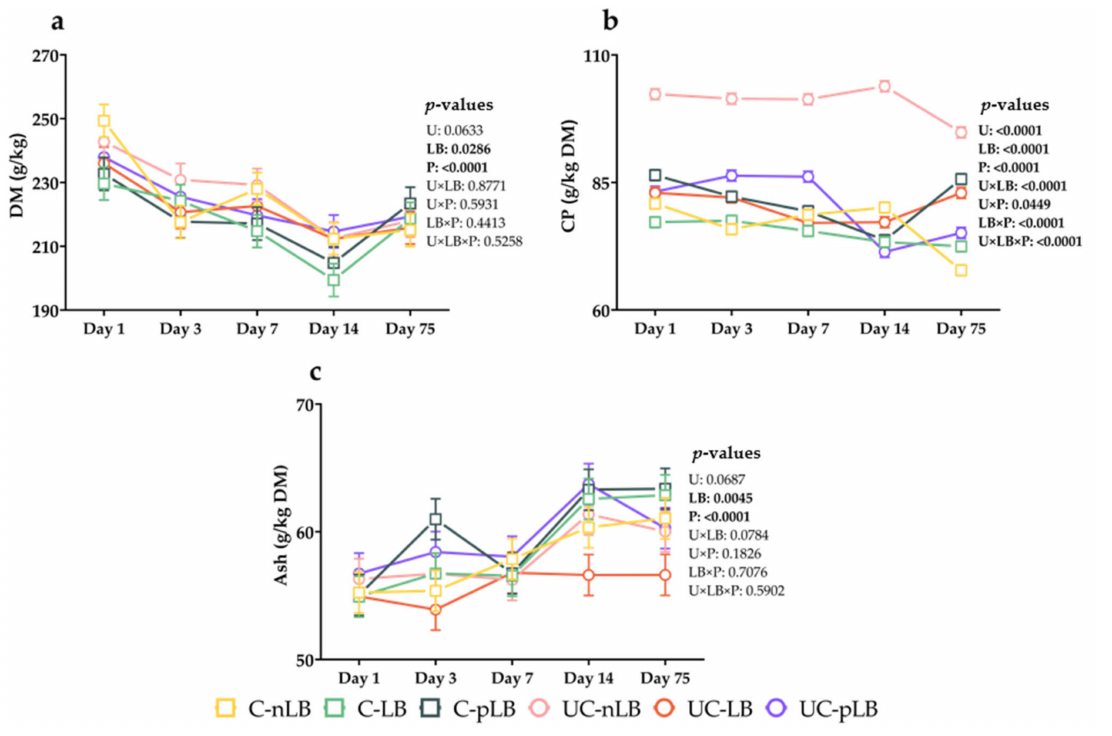
Figure 2. Effect of the ensiling length, the treatment with urea, and preactivation of L. buchneri on the chemical composition of the corn silages. Changes in dry matter [DM, ( a )], crude protein [CP, ( b )], and ash ( c ) content. C: corn silages not treated with urea, UC: corn silages treated with 1.0% urea on dry matter basis, C-nLB: corn silages not treated with urea and uninoculated with L. buchneri , C-LB: corn silages not treated with urea and inoculated with L. buchneri , C-pLB: corn silages not treated with urea and inoculated with preactivated L. buchneri , UC-nLB: corn silages treated with urea and uninoculated with L. buchneri , UC-LB: corn silages treated with urea and inoculated with L. buchneri , UC-pLB: corn silages treated with urea and inoculated with preactivated L. buchneri . Factors that are statistically significant are highlighted in bold ( p <